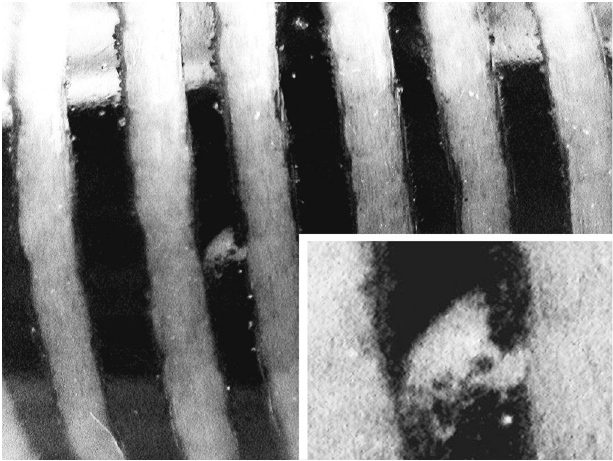
FIG. 1. A discontinuity or “ microbreak ” in the resistor film (black) is seen in the third turn from the left on a Welwyn 982 M Ω post resistor. Rounded edges of the resistor film in the microbreak suggest possible localized vaporization of the film due to high-instantaneous voltage. Inset shows the magnified image of the